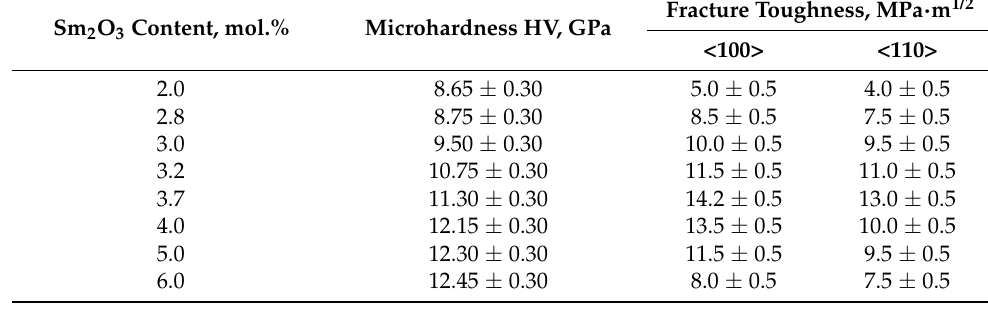
Table 2. Microhardness and fracture toughness of (ZrO 2 ) 1 − x (Sm 2 O 3 ) x crystals.